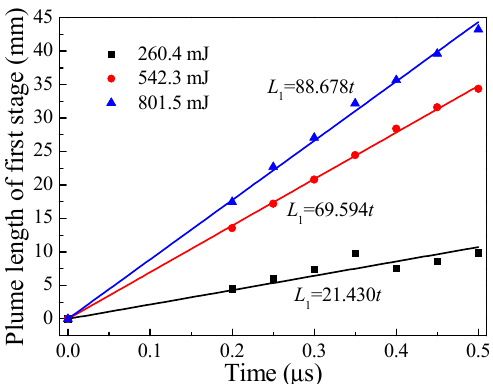
Figure 15. The plume length of first stage variation with time and its linear fitting at different energies (ambient pressure 0.005 Pa and 26.5% Al).